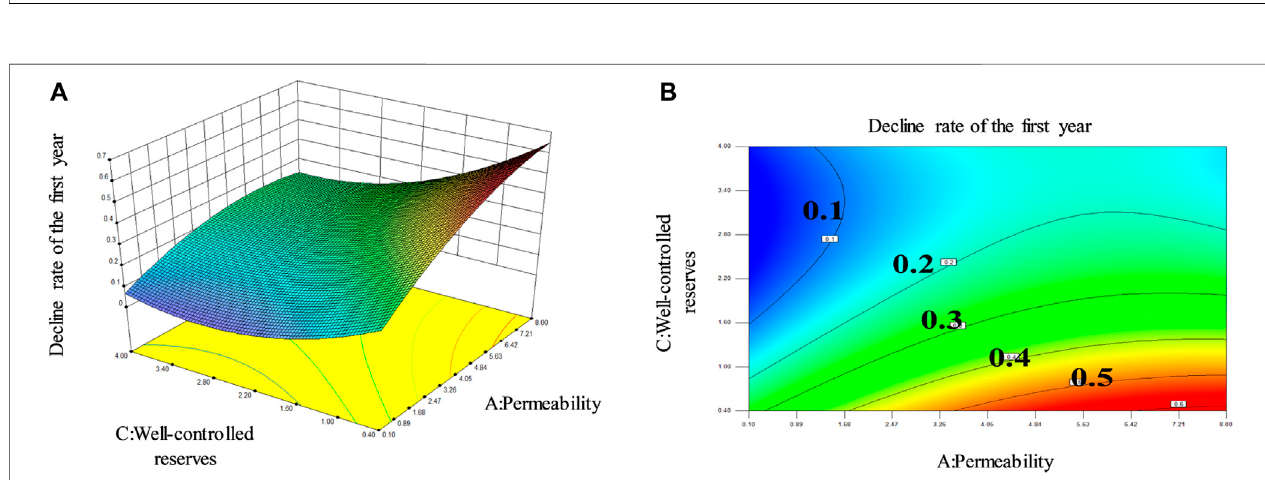
FIGURE 9 | Analysis diagram of response surface; (A) Three-dimensional diagram; (B) Two-dimensional diagram.